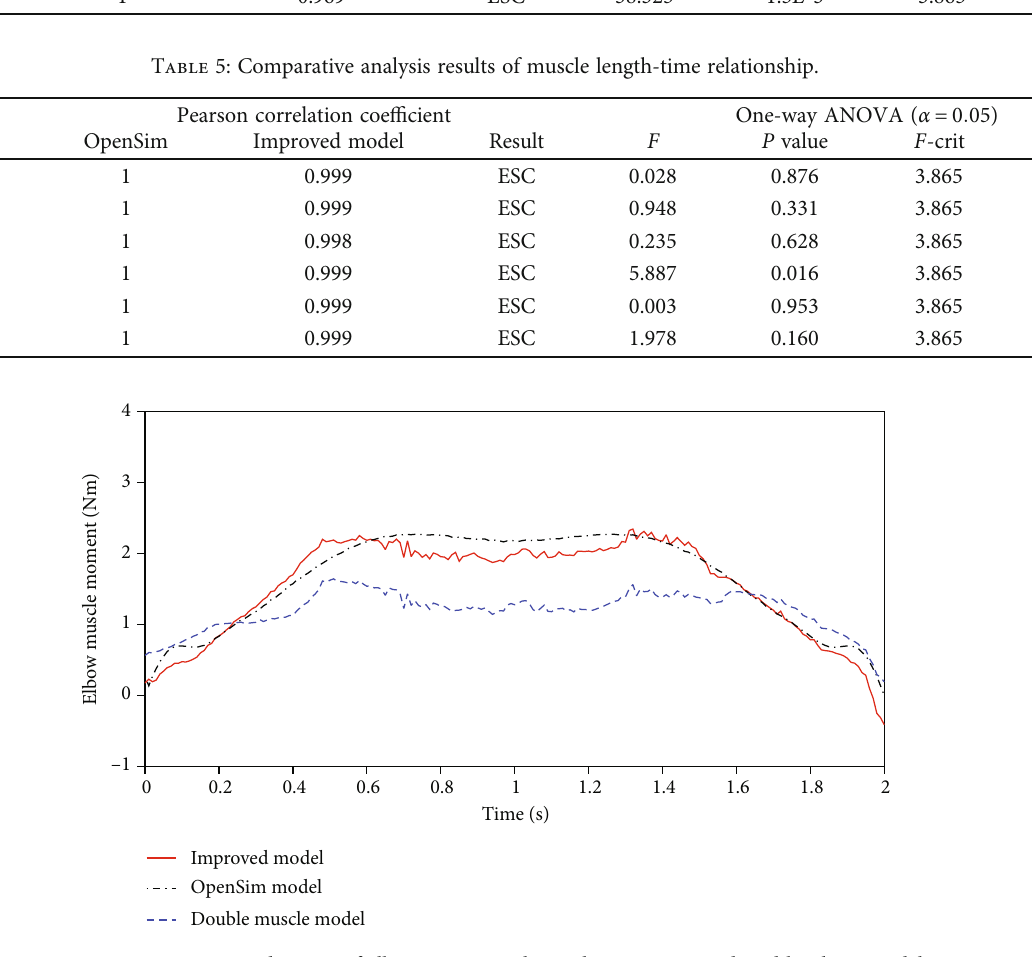
Figure 11: Comparative diagram of elbow joint muscle resultant torque predicted by three models. Table 6: Comparative analysis of the predicted resultant moment- time